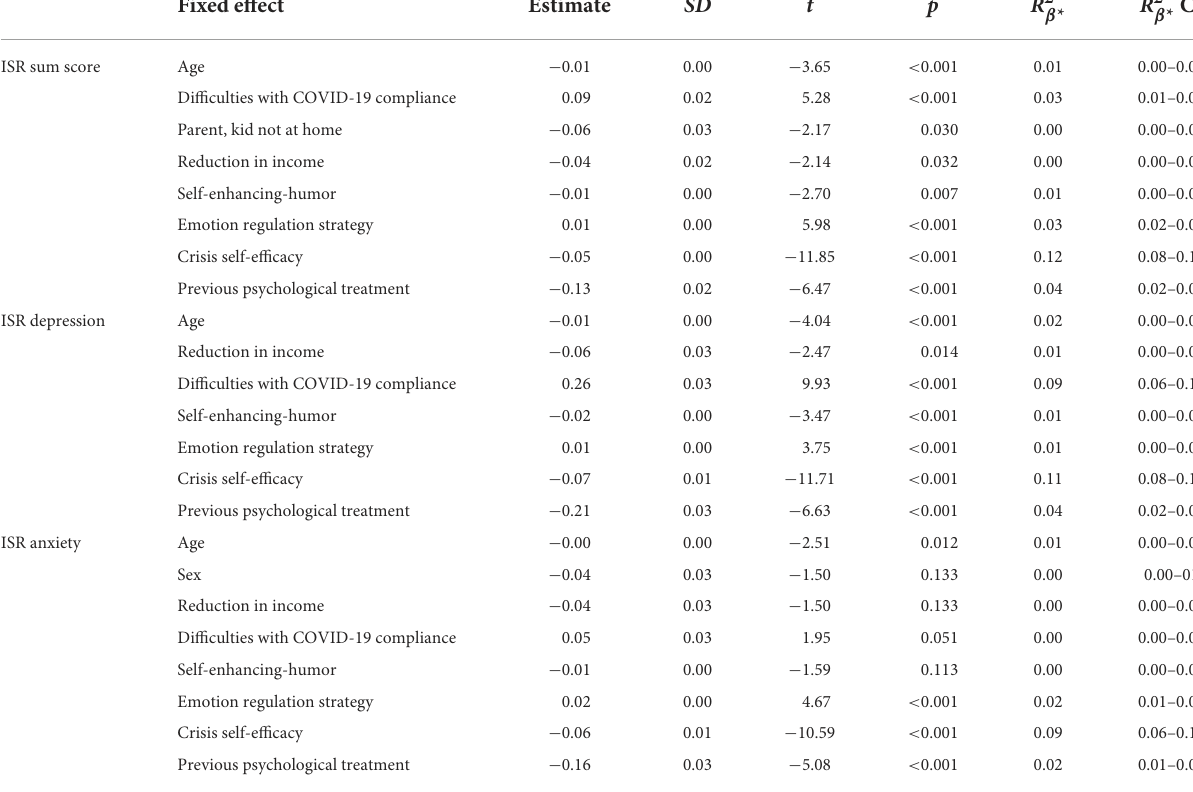
TABLE 4 Main fixed effects of interest within LMEs predicting ISR